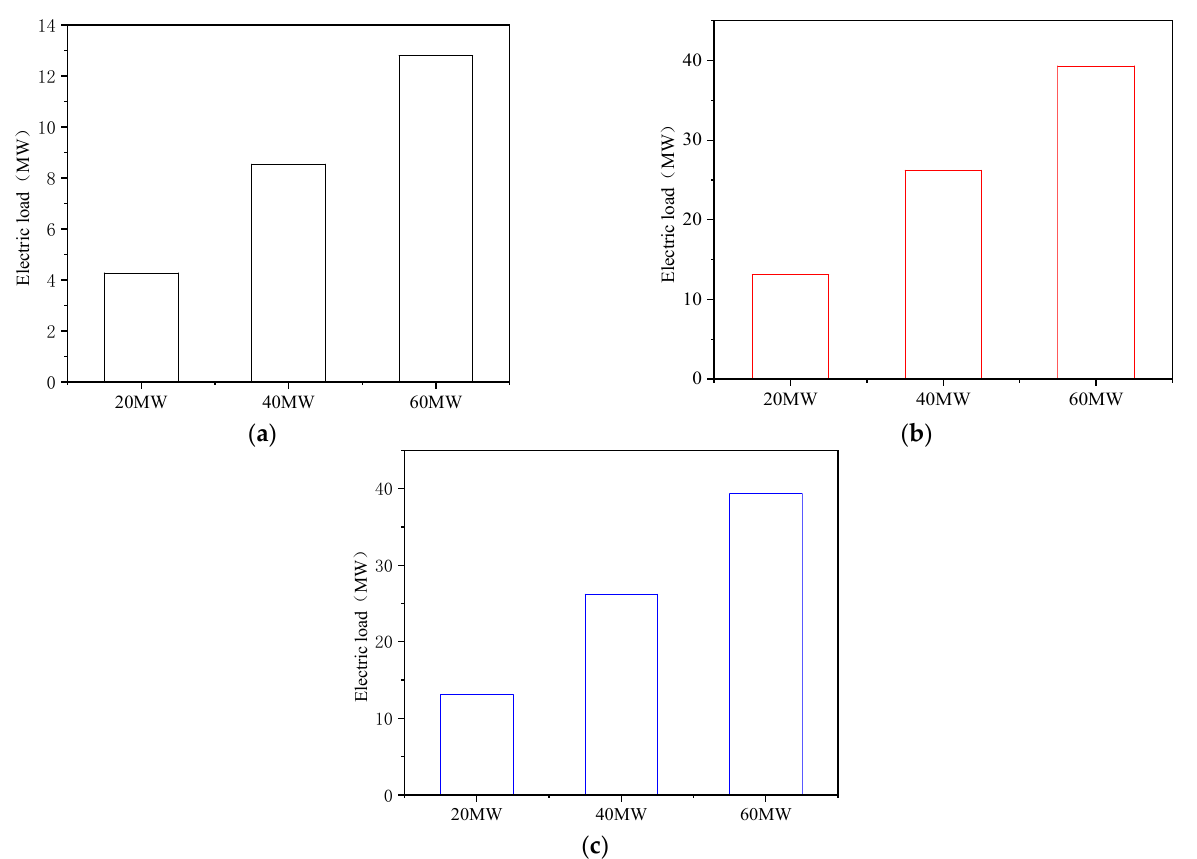
Figure 7. New peak regulating capacity of the coupled system in the heat-release process. ( a ) R1; ( b ) R2; ( c ) R3.